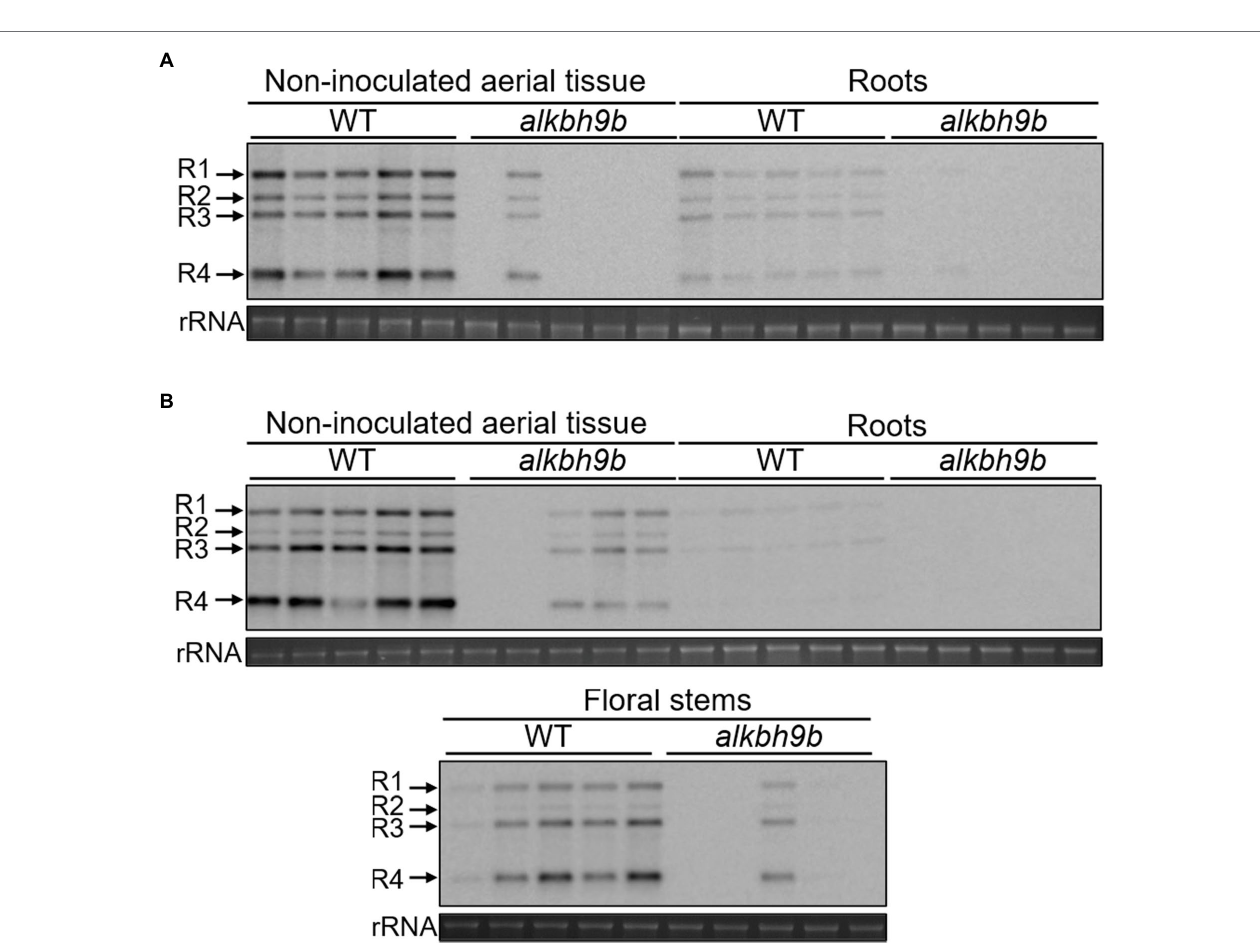
FIGURE 2 | AMV systemic infection of diverse tissues is severely impaired in alkbh9b plants. Representative northern blots of different tissues (indicated on top of each panel) from five WT and alkbh9b plants at 11 (A) and 15 (B) dpi. Five biological replicates of each tissue are shown. Positions of the vRNAs are indicated on the left. Ethidium bromide staining of ribosomal RNAs (rRNA) was used as RNA loading